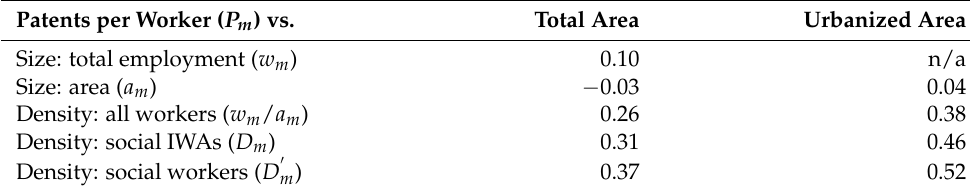
Table 2. Correlation coefficients ( R ) of MSA patenting rates versus workforce characteristics using two definitions of MSA area. Using effective urbanized area gives consistently larger R values. Patents per Worker ( P m ) vs. Total